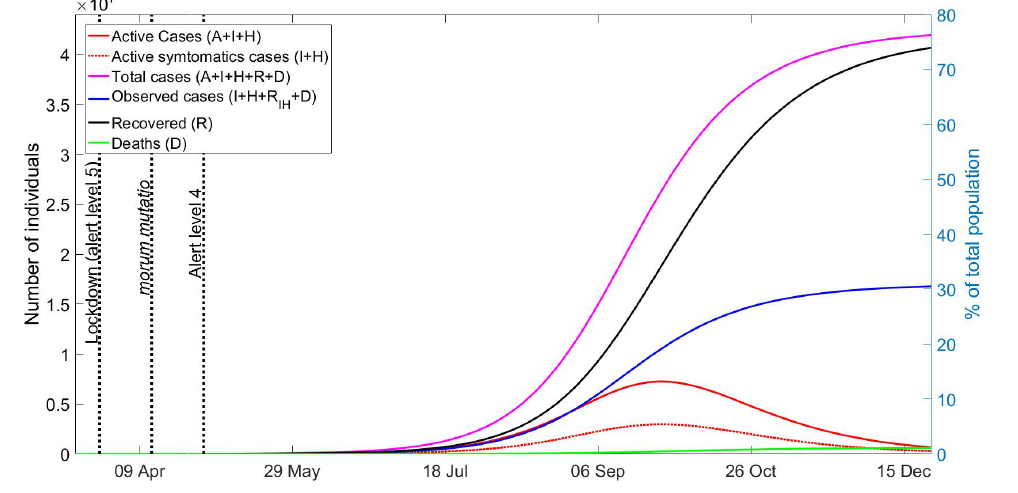
Fig. 6. Long term dynamics with ρ = 0 . 4